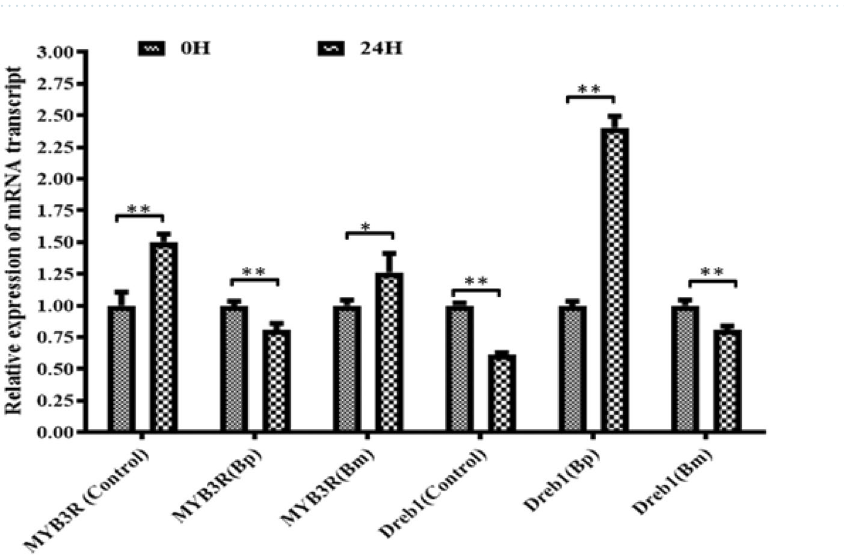
Figure 8. Quantitative analysis of expression of Dreb1 and MYB3R gene in leaves of wheat plants grown from seeds treated with Bp and Bm. Here, Bp and Bm indicate B. pseudomycoides and B. massilioanrexius, respectively. Data were recorded after 24 h of drought stress induction. Here, * indicates significance at the P = 0.05 level, and ** indicates significant at P =